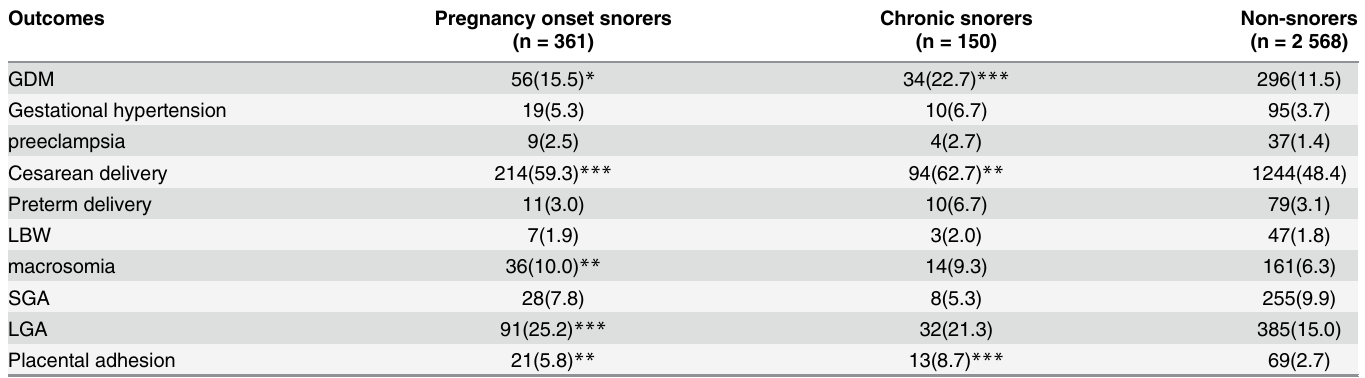
Table 2. Comparisons of the incidence of adverse pregnancy outcomes among groups.